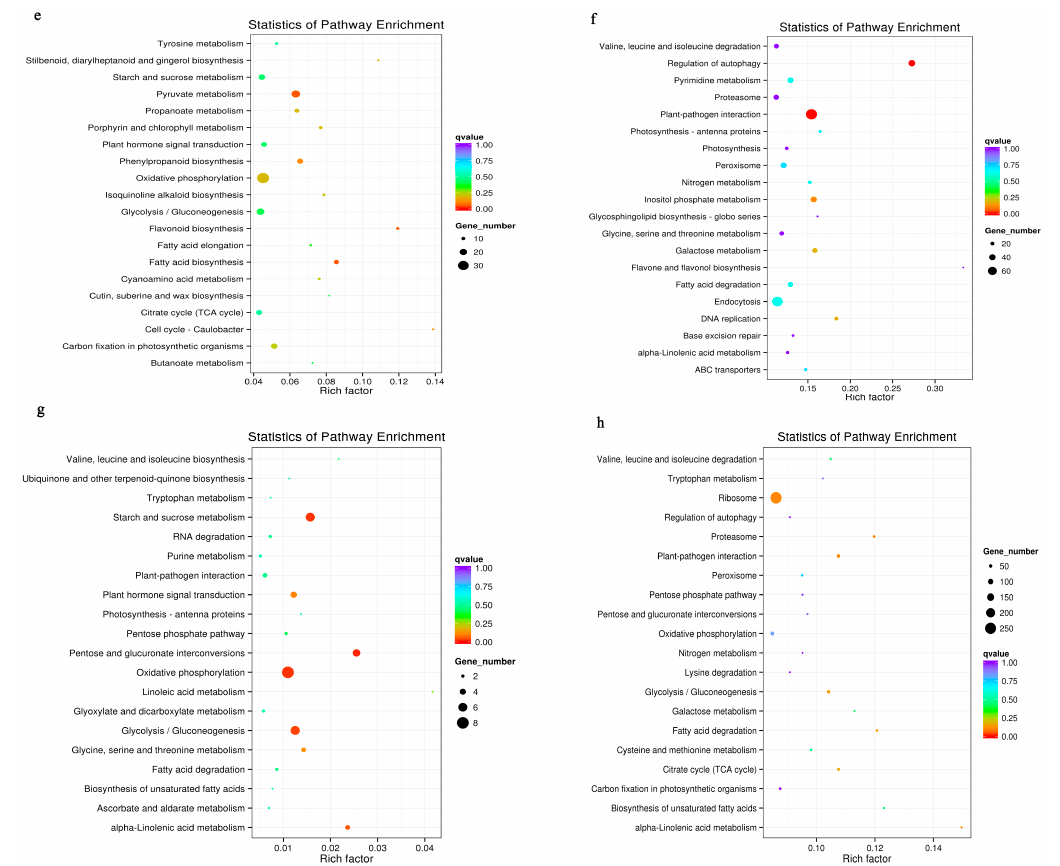
Figure 4. Metabolic pathways enrichment under salt stress conditions. Enriched pathways of upregulated unigenes ( a – d ); ( a ) Enriched pathways of upregulated unigenes in NY leaves (NYL) underlying salt treatment vs. control; ( b ) Enriched pathways of upregulated unigenes in NY roots (NYR) underlying salt treatment vs. control; ( c ) Enriched pathways of upregulated unigenes in TC leaves (TCL) underlying salt treatment vs. control; ( d ) Enriched pathways of upregulated unigenes in TC roots (TCR) underlying salt treatment vs. control. Enriched pathways of downregulated unigenes ( e – h ); ( e ) Enriched pathways of downregulated unigenes in NY leaves (NYL) underlying salt treatment vs. control; ( f ) Enriched pathways of downregulated unigenes in NY roots (NYR) underlying salt treatment vs. control; ( g ) Enriched pathways of downregulated unigenes in TC leaves (TCL) underlying salt treatment vs. control; ( h ) Enriched pathways of downregulated unigenes in TC roots (TCR) underlying salt treatment vs.